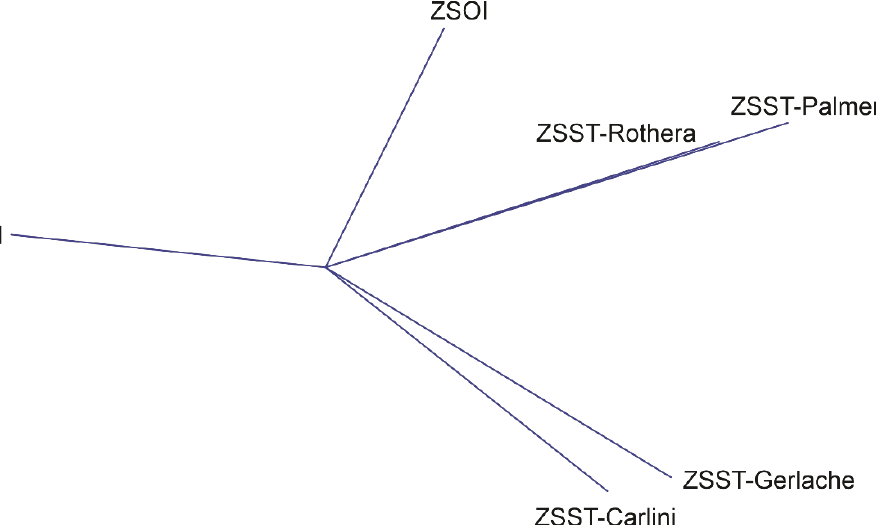
Figure 7. Multidimensional vector plot derived from a factor analysis of the Z SST , Z SAM , and Z SOI in the WAP. The plot shows the loadings of each variable in the eigenvector matrix. As a vector multidimensional plot, this figure has no axes.